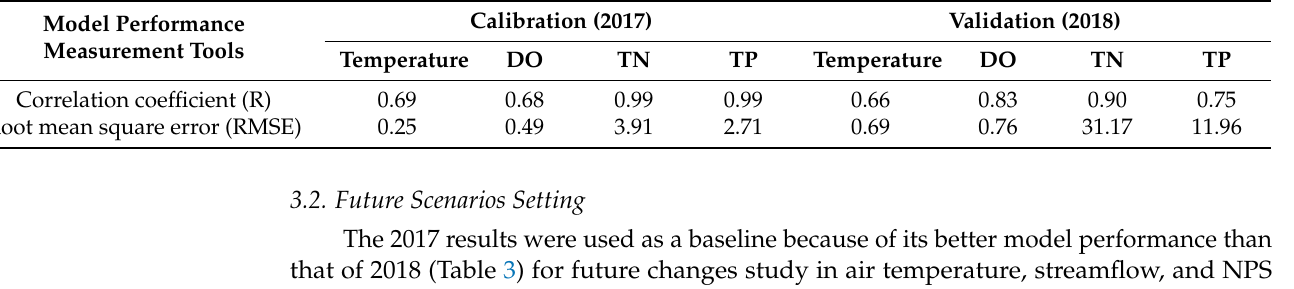
Figure 4. Model annual average water temperature and DO/TN/TP concentrations along the Shoalhaven River in 2018 compared with observations (model validation).